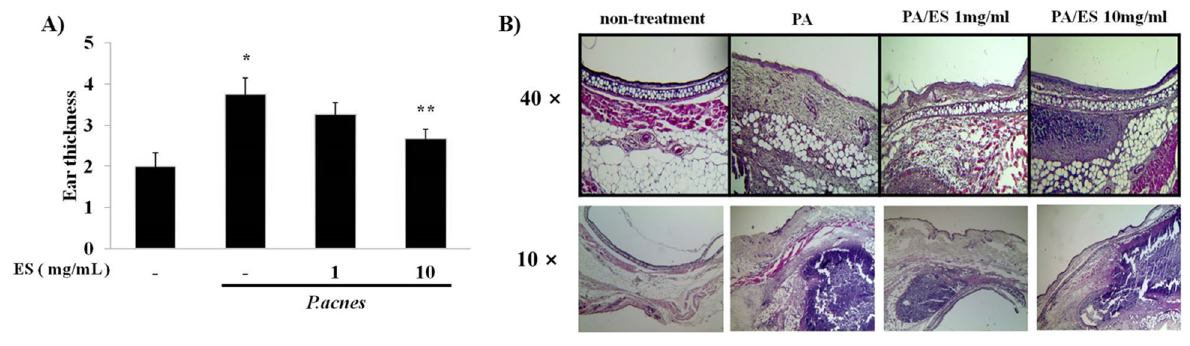
Fig. 5 Effect of ES on ear thickness in living P. acnes -injected mice ears. ( a ) The suppress effects with 1, 10 mg/ml of ES on P. acnes -induced ear edema in mice were evaluated by measuring the ear thickness. ( b ) Paraffin sections of Ear tissue were stained with H&E observed by microscope. Values represent mean ± S.E.M. ( n = 5). Data were analyzed by Tukey post hoc test ( * p < 0.05 versus control and ** p < 0.05 versus P.acnes